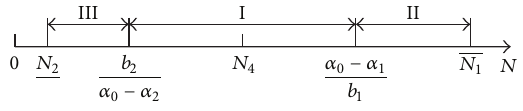
Figure 6: The optimal compensation mechanism in different